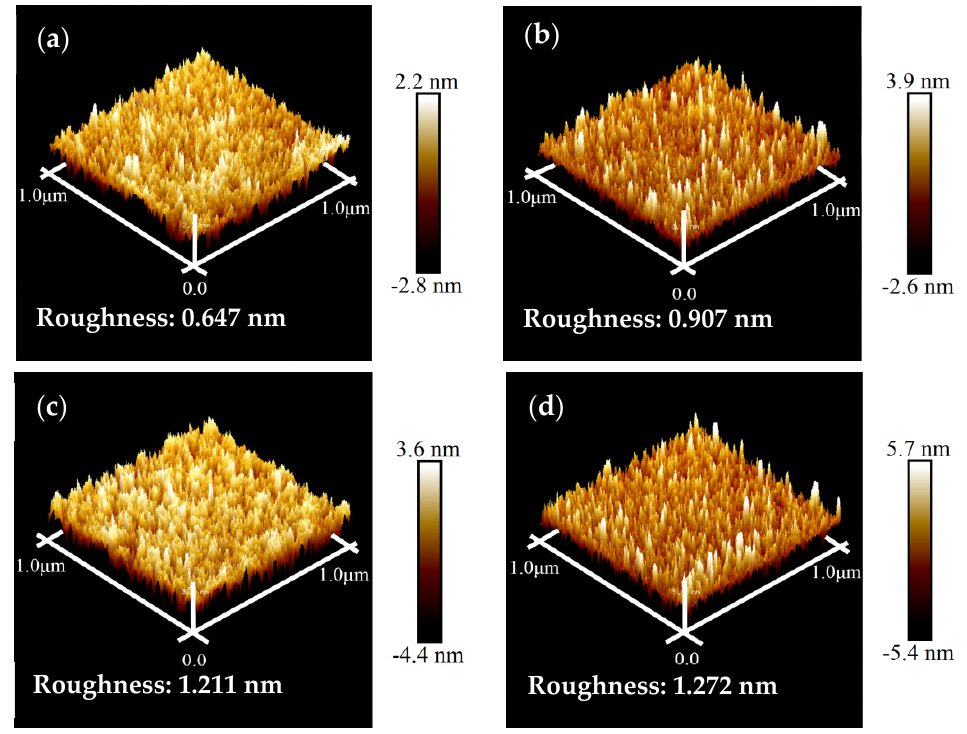
Figure 3. AFM images of COOH-APTMS/SiO 2 /Si with different modification times: ( a ) 1 h; ( b ) 2 h; ( c ) 3 h; ( d ) 4 h.